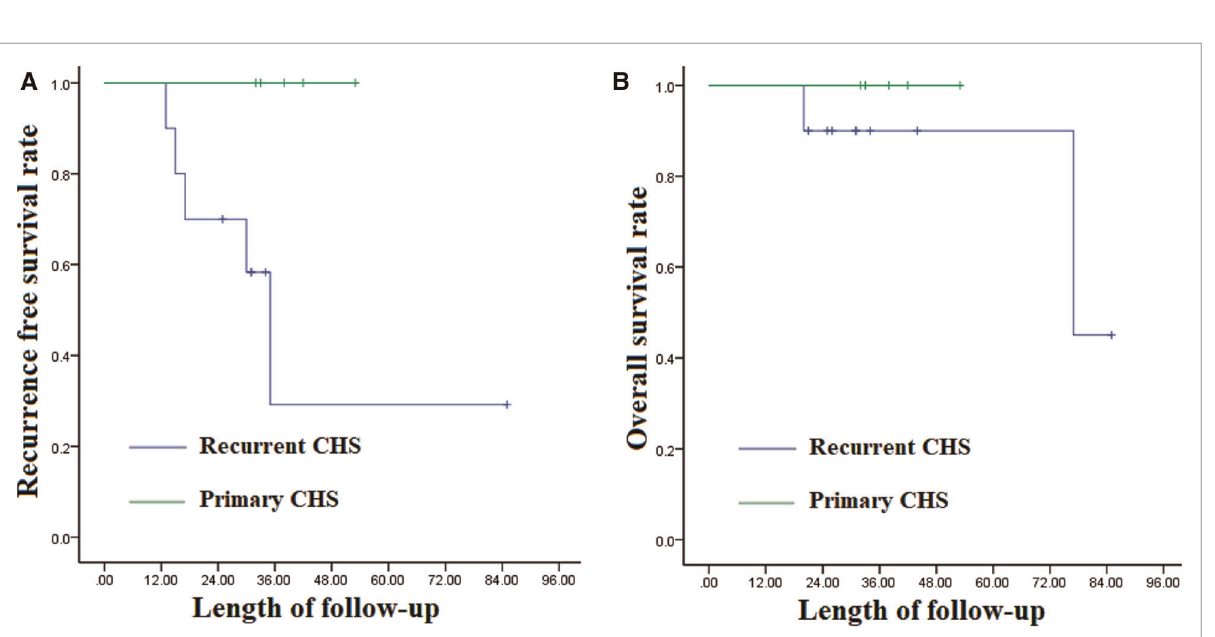
FIGURE 4 ( A ) the Kaplan-Meier curves of recurrence free survival between primary and recurrent thoracic spinal chondrosarcoma; ( B ) the Kaplan-Meier curves of overall survival between primary and recurrent thoracic spinal